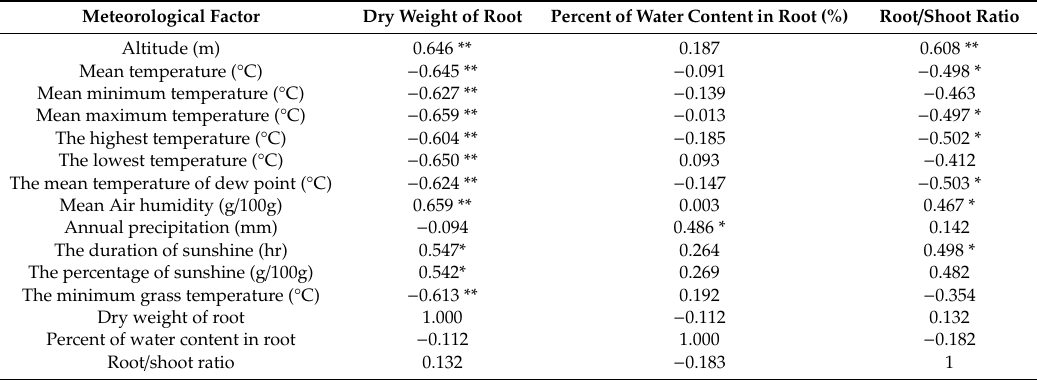
Table 4. Correlation coe ffi cients between root growth characteristics and meteorological factors in Angelica gigas Nakai cultivation sites, Korea.